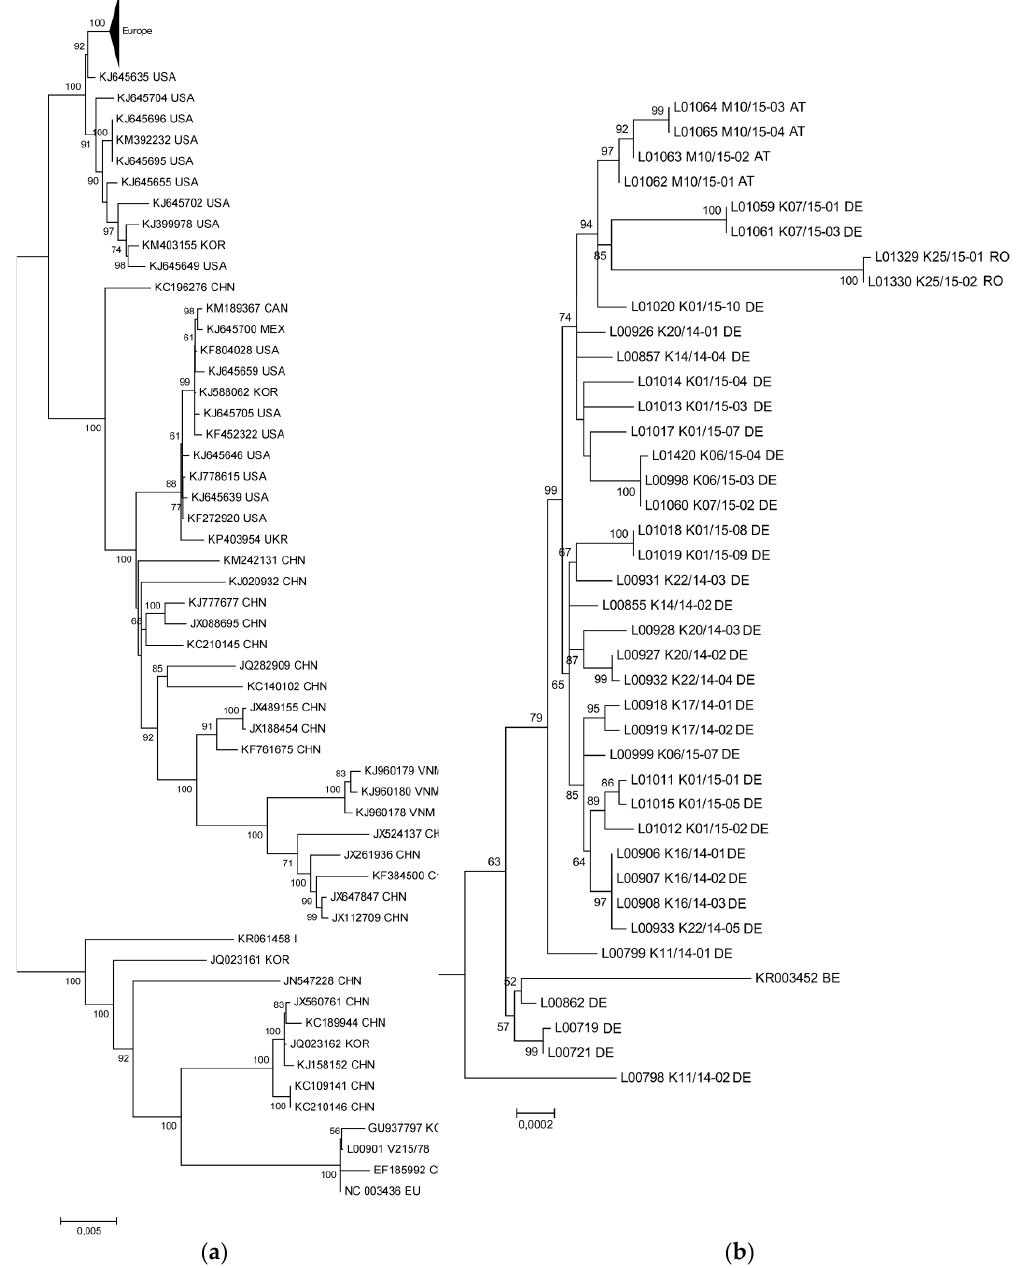
Figure 1. Phylogram generated from 91 PEDV sequences using the Maximum Likelihood algorithm in Mega 6.06 [22]. With General Time Reversible model with Gamma distribution. The phylogram was tested by 1000 bootstrap replicates, branch lengths are measured in the number of substitutions per site (see scale bars). ( a ) European samples in the worldwide context. ( b ) Clustering of European samples. Enlargement of the European cluster (triangle in figure part ( a )).